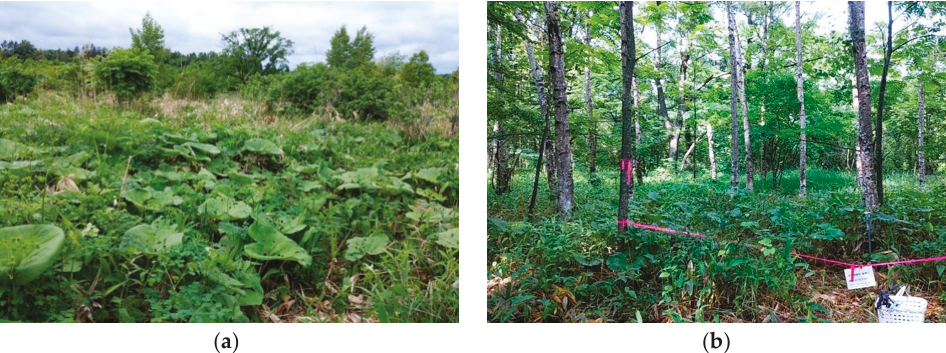
Figure 2. The study sites, ( a ) the clearing and ( b ) the understory, in the Forest of Obihiro. Photographs were taken on ( a ) June 28 and ( b ) 3 July 2020 by Kohei